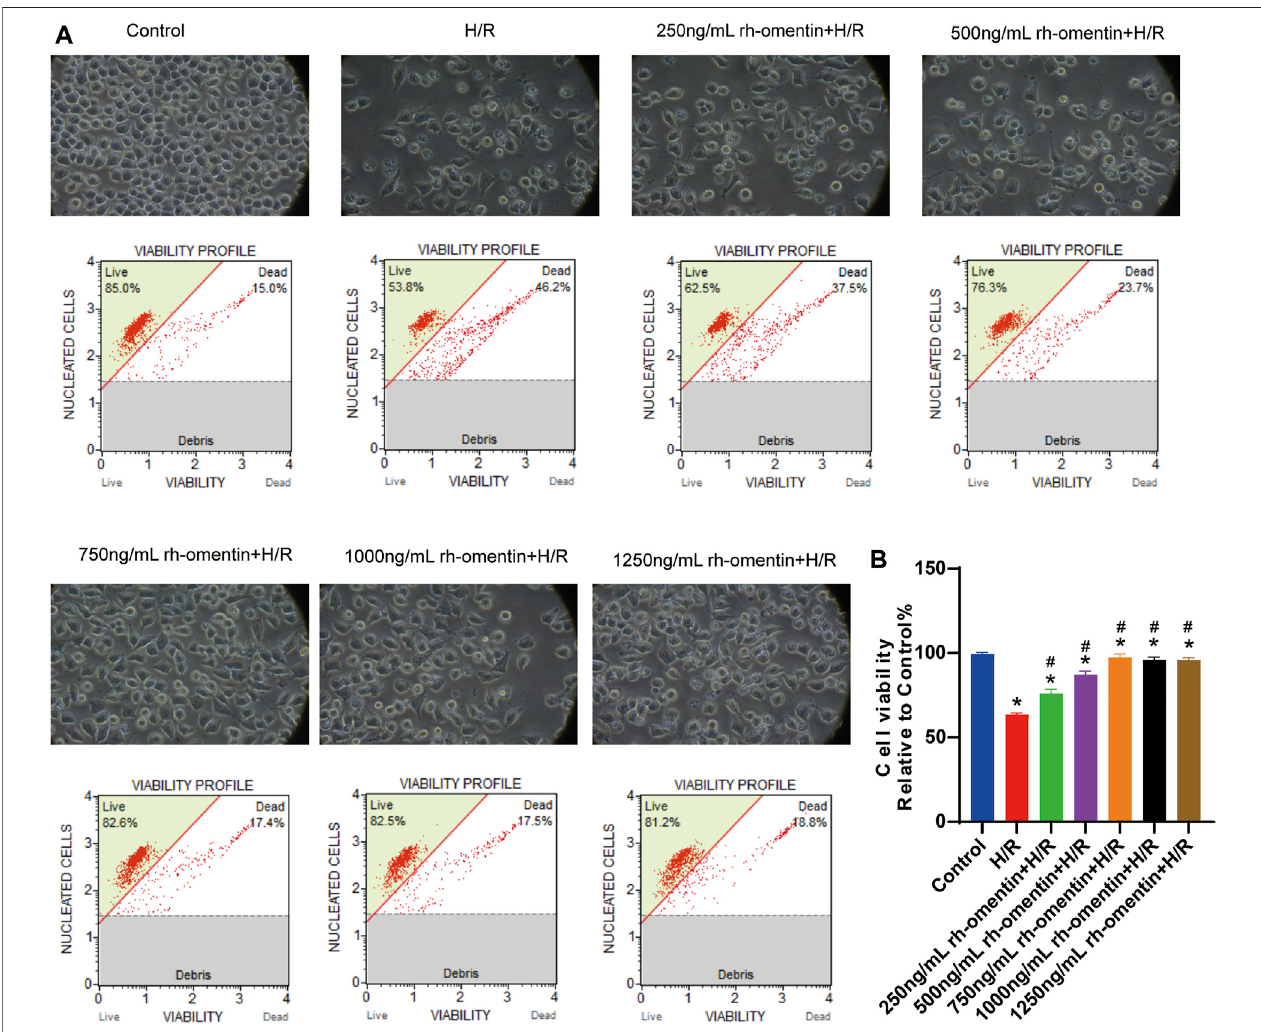
FIGURE 3 | Rh-omentin protected N2a cells against H/R-induced injury. (A) N2a cells were treated with rh-omentin at the different concentrations and then exposed to H/R injury, followed by detection of cell viability. (B) Statistical graph of cell viability. Error bars show the standard deviation for n (cid:2) 6 measurements from representative experiments. * p < 0.05 vs the Control group; # p < 0.05 vs. the H/R group.